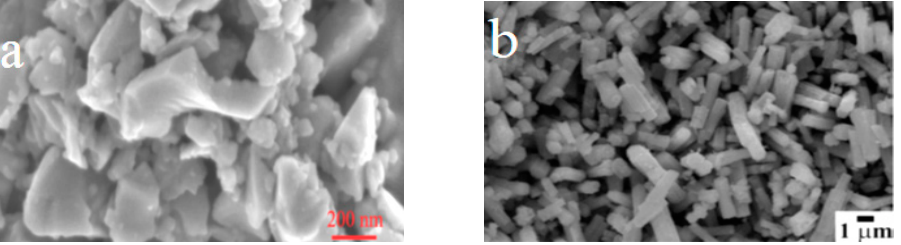
Figure 5. SEM images of different perovskites structures: ( a ) double perovskite PrBaCo 2 O 5+ δ [68]; ( b ) NiTiO 3 rods [59].